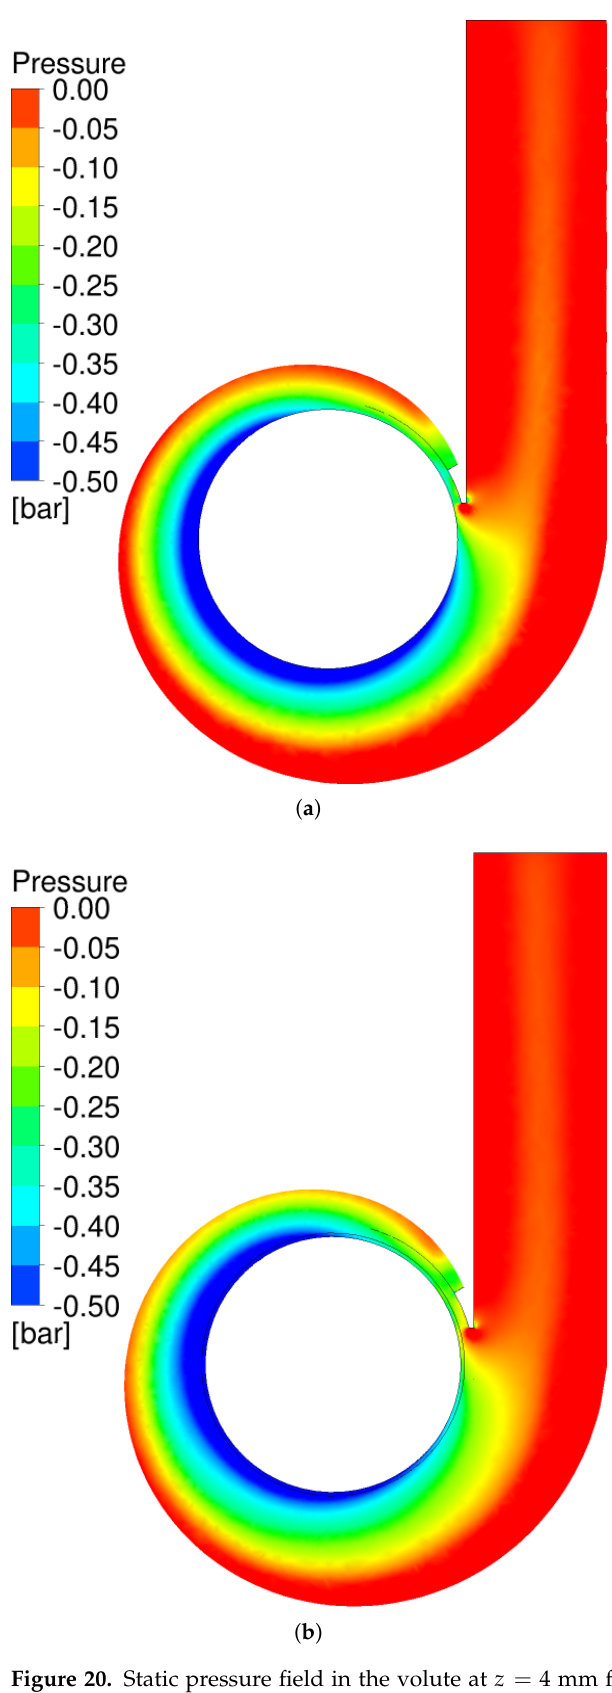
Figure 20. Static pressure field in the volute at z = 4 mm for the baseline ( a ) and the